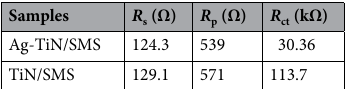
Table1. Parameters obtained from the fitting curves of EIS in Fig. 7.